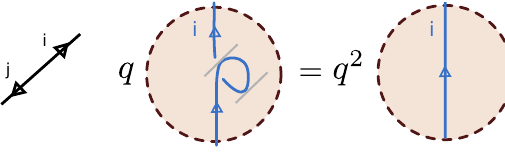
Figure 69 . Applying F to the l.h.s. of skein relation (I) in Sk( M; gl (2)).